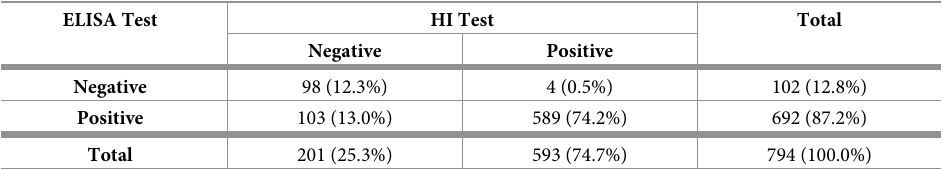
Table 2. Results of the ELISA and HI test.